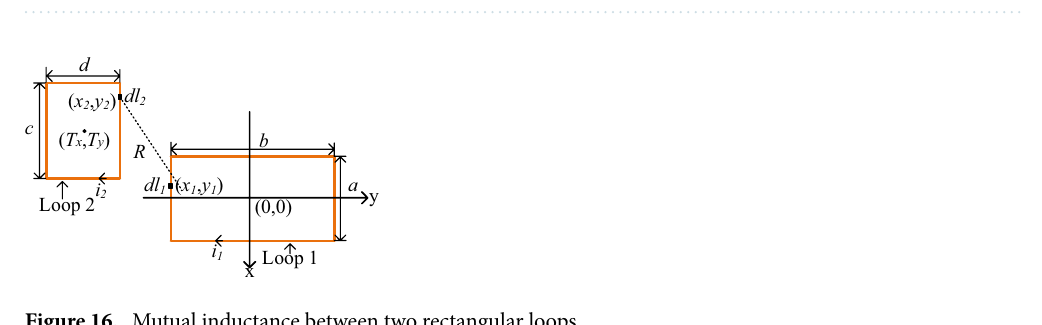
Figure 15. Simulation results of mutual inductance M trans varies with plug structure parameters.